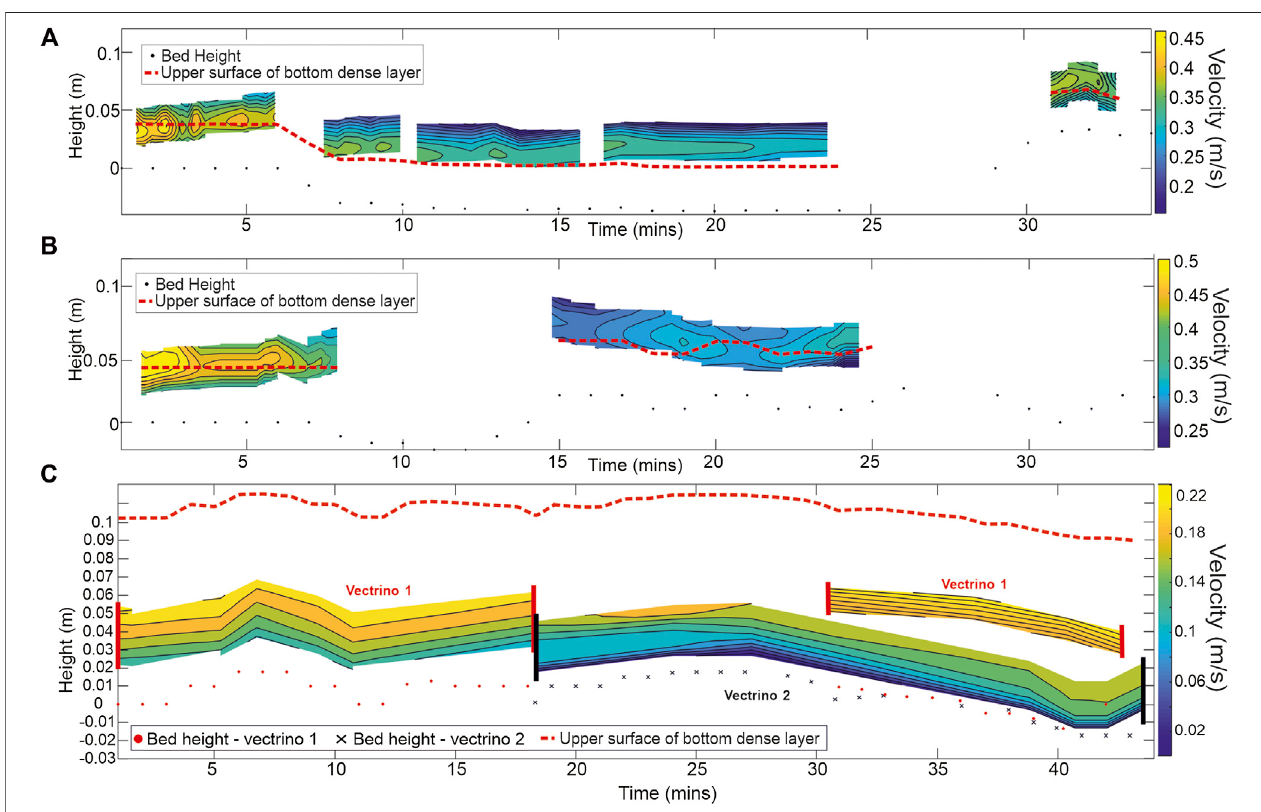
FIGURE5| ContourplotsofthedownstreamvelocitycomponentthroughoutExperiments1(supercriticalsteady fl ow) (A) and2(supercriticalwaning fl ow) (B) .The dashed red lines identify the height of the upper surface of the lower denser layer of the density current. The black dots indicate the height of the substrate beneath the vectrino. (C) Contourplot of the downstream velocity component throughout Experiment 4(subcritical waning fl ow),recorded within the bottom dense layer of the fl ow. Velocity measured between 0 – 18 and 33 – 43 min was recorded by vectrino one which was positioned higher above the bed. Velocity measured between 18 and 44 minwasrecordedbyvectrino2,positionedlowerinthe fl ow.Thereddotsindicatetheheightofthesubstratebeneathvectrinooneandtheblackcrossesindicatethe height of the substrate beneath vectrino 2.